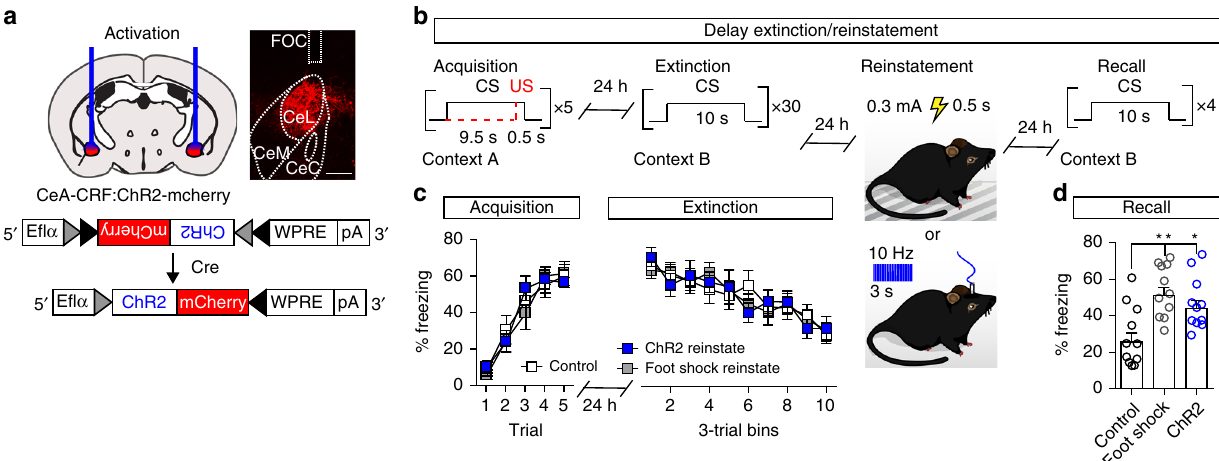
Fig. 7 CeA – CRF neurons mediate fear reinstatement. a Schematic of AAV1-FLEX-ChR2-mCherry expression and bilateral optical fi ber placement in the CeA of CRF-Cre mice with representative histological veri fi cation of ChR2-mCherry expression and cannula placement. Control mice and US reinstatement mice were injected with AAV1-FLEX-mCherry. b Schematic of fear conditioning paradigm. Following delay extinction mice were given a single US presentation (0.3 mA, 0.5 s) or a single optical stimulation (10 Hz, 3 s) in the extinction context ( n = 11/group). c Freezing responses to CS during acquisition (left) and delay extinction (right). d Freezing to CS presentation during extinction recall following reinstatement (One-way ANOVA followed by Bonferroni multiple comparisons, ** P < 0.01, * P < 0.05). Data are presented as mean ±